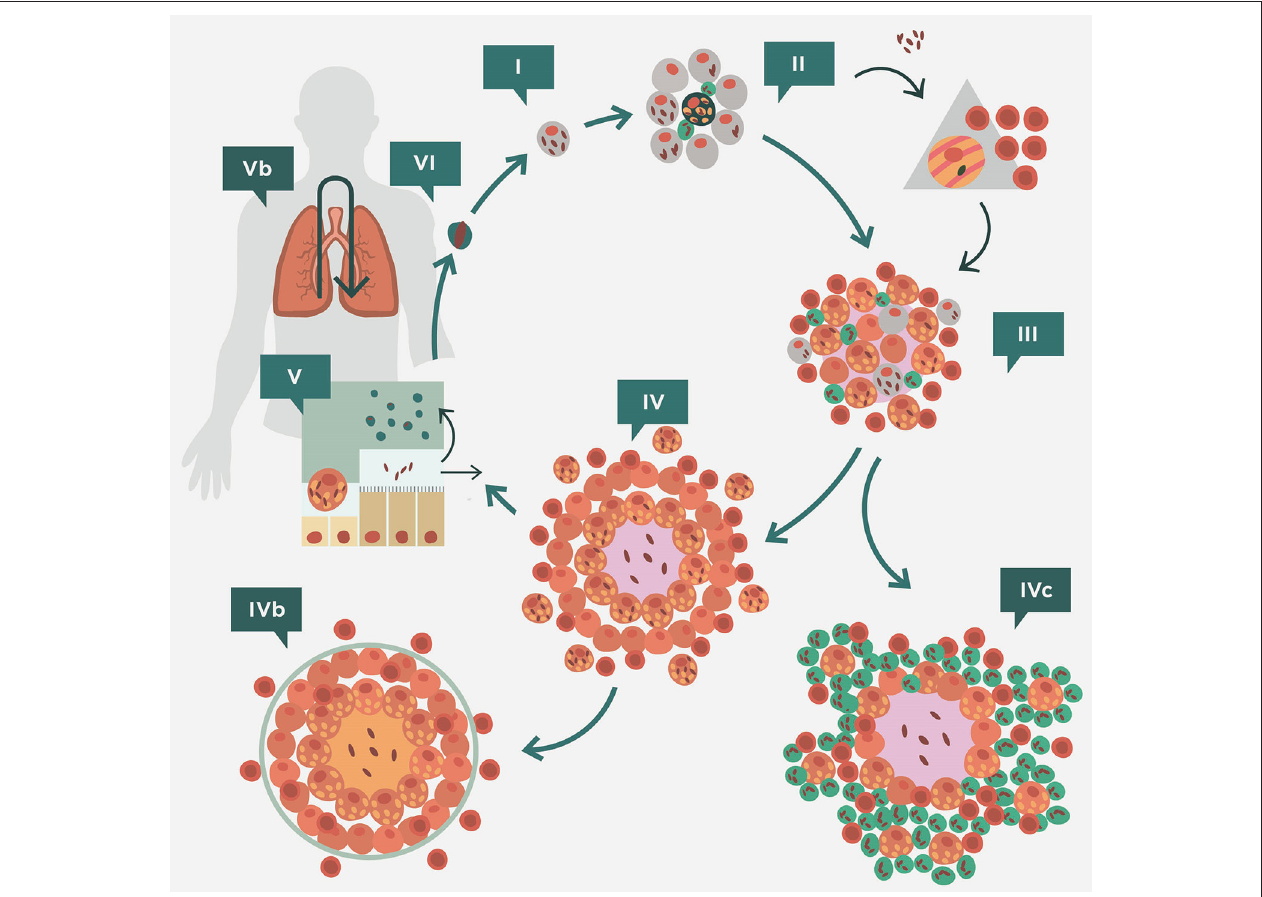
FIGURE 3 | Life cycle of Mycobacterium tuberculosis in the lungs according to the dynamic hypothesis. After transmission via aerosol, M. tuberculosis settles in the alveoli. (II) M. tuberculosis grows inside alveolar macrophages (AM), causing their necrosis. These cells cause a weak, if any, inflammatory response and the bacilli released are simply phagocytosed by neighboring AMs, causing no lesion. This “unicellular” phase (I) allows the bacilli complete freedom to constantly generate new infectious foci, even in those hosts that have optimal cellular immune responses. This is because of the lack of antibodies in the alveoli to inactivate the bacilli and the fact that infected AM do not induce a sufficient inflammatory response to be detected by specific lymphocytes. Once the inflammatory response is sufficiently intense due to the large number of neighboring infected AMs, the alveoli break their sealed nature, thus allowing the entry of cells from the capillary net and the drainage of the bacilli toward the lymphatic vessels and regional lymph nodes, where antigenic presentation and lymphocytic proliferation take place (II). These lymphocytes are attracted to the inflammatory foci, where they activate the infected AM and destroy the bulk of the bacilli (around 90%); the survivors become non-replicating (NR-Mtb) and rest inside activated AMs or necrotic tissue (III). Once bacillary growth has been controlled, the “cleaning” phase starts. This phase is characterized by phagocytosis of the necrotic debris by the activated AMs, which retain even more NR-Mtb and become “foamy” by accumulating cellular debris (IV). These foamy macrophages are then progressively drained with the alveolar fluid toward the bronchi, where they are destroyed. The bacilli contained therein can pass into internal aerosols (V) and are able to reinfect tissue (VI), although they are mainly drained toward the intestinal tract (VI). This cycle can be interrupted by encapsulation, which isolates the granuloma. This process occurs as a result of the interlobular septae, which contain fibroblasts that are very sensitive to the mechanical changes caused by intraparenchymal lesions (IVb). Some hosts can develop an intense neutrophilic response, which is the origin of cavitated lesions (IVc). Version from Vilaplana and Cardona